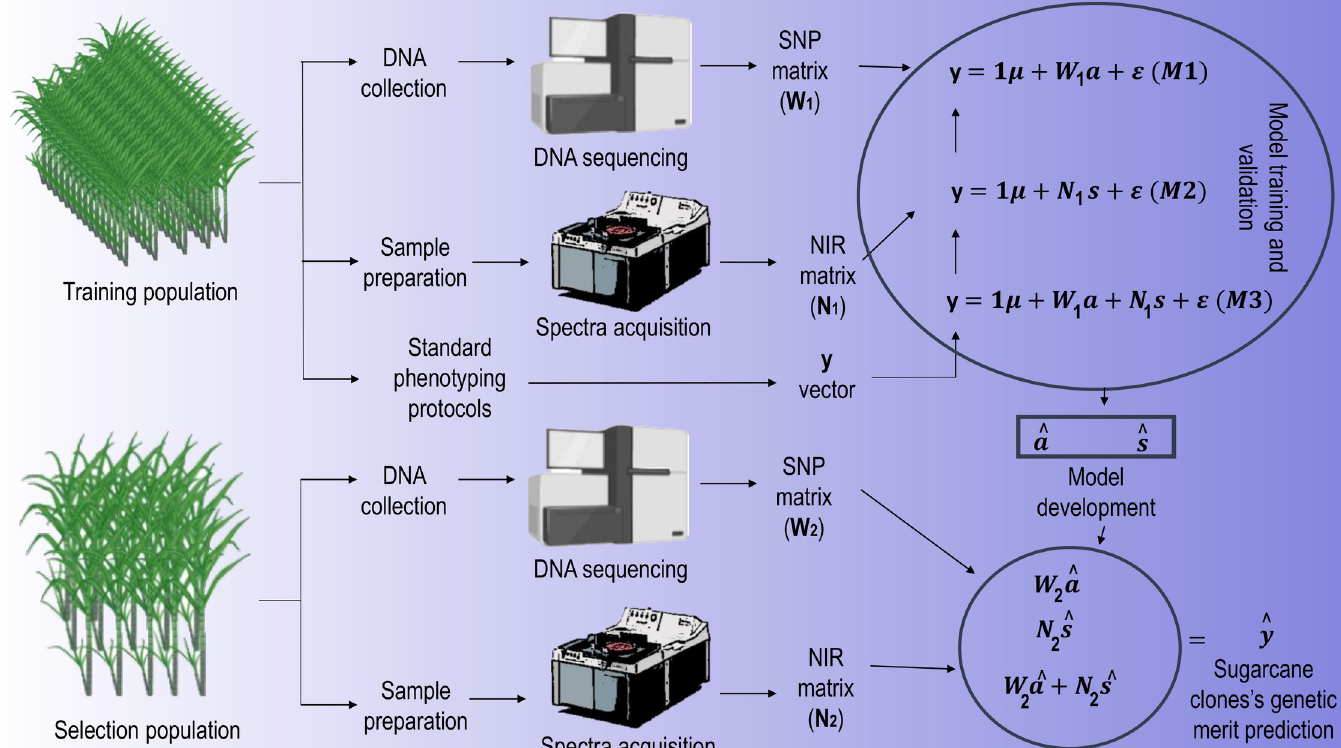
Fig 2. Schematic diagram of the experimental procedure. Created with